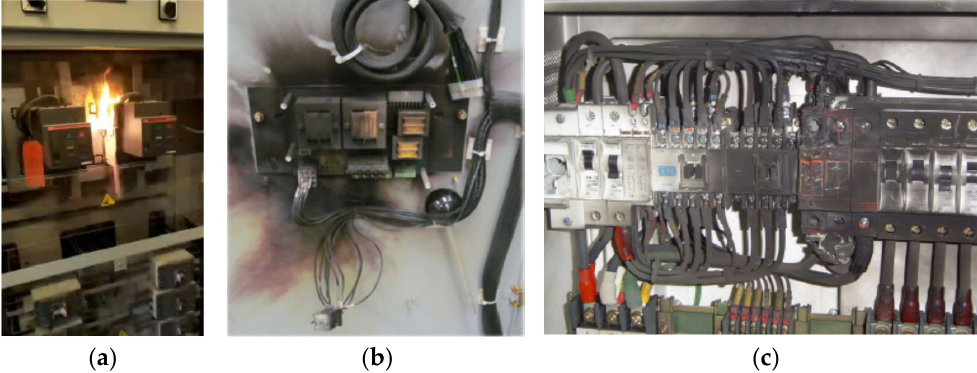
Figure 2. A display of electrical equipment damage caused by a short circuit: ( a ) a short circuit resulting in fire; ( b ) fire damage in equipment of a thunderstorm lightning protection system; ( c ) damages on the editing equipment caused by fire.